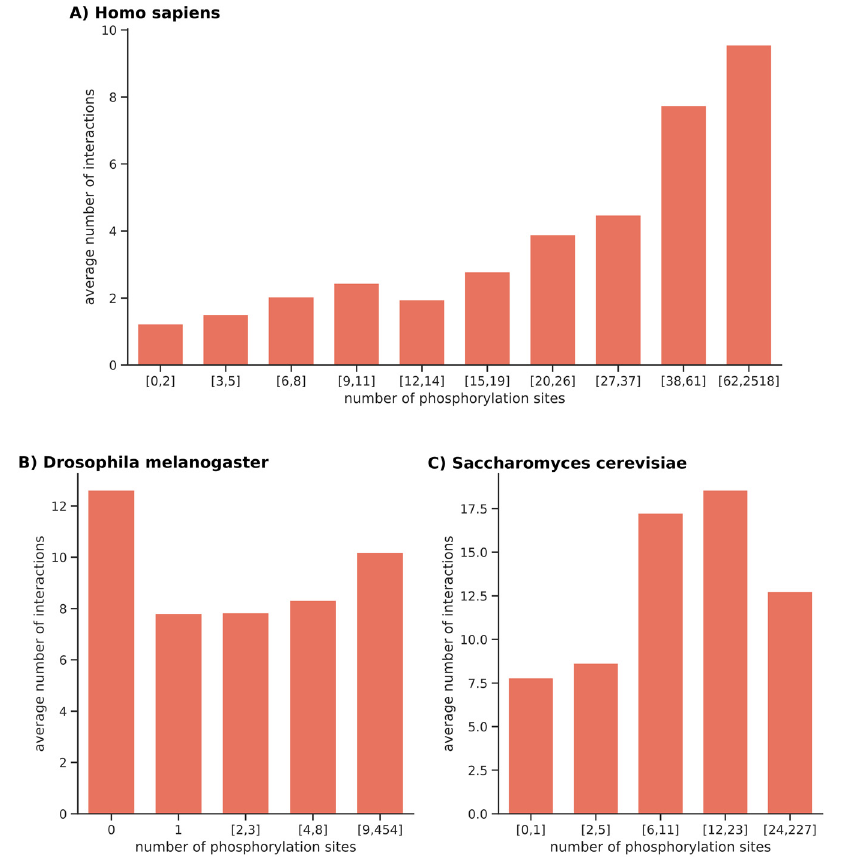
Figure 5. Average number of interactions per protein in function of its number of phosphorylation sites. Each bar represents a bin. The closed intervals, in terms of the number of phosphorylation sites defining a bin, are given on the x-axis. The average number of interactions for proteins belonging to each bin is given in the y-axis. ( A ) For H. sapiens , each bar represents a decile. ( B ) For D. melanogaster , the non-phosphorylated proteins constitute the first bin, and the remaining proteins are divided into quartiles. The height of the first bar, which represents the category of non-phosphorylated proteins, cannot be compared to the others because it contains seven times more proteins and the probability of obtaining interactions in this network is much higher. ( C ) For S. cerevisiae , each bar represents a quintile. Table 3. Interaction data for D. melanogaster proteins depending on their rate of phosphorylation. Ranges